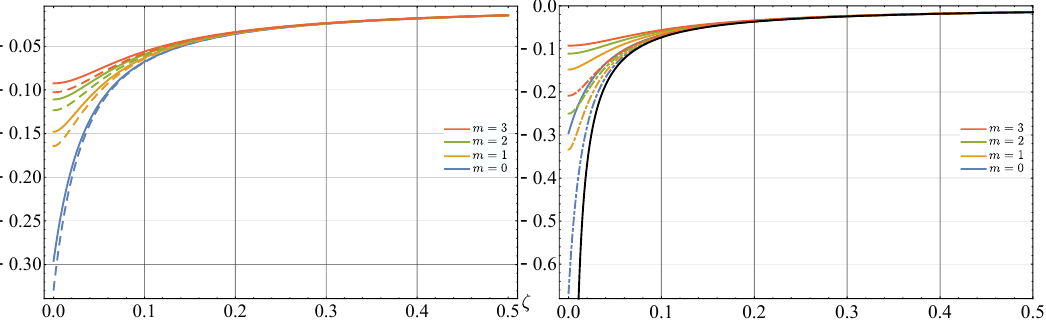
Figure 2. (color online) Effective potentials (in units of the electron rest energy Mc 2 ) as functions of the distance ζ = z /¯ λ c for B = 10 8 . The left panel displays the effective potentials (16) (solid lines) and their corresponding saturation curves (19) (dashed lines). In the right panel, the solid colored lines are the same as in the left panel while the dot-dashed lines refer to effective potentials neglecting vacuum polarization, given by Equation (16) with ε ⊥ = ε (cid:107) = 1. The solid black line corresponds to the large-distance Coulomb potential